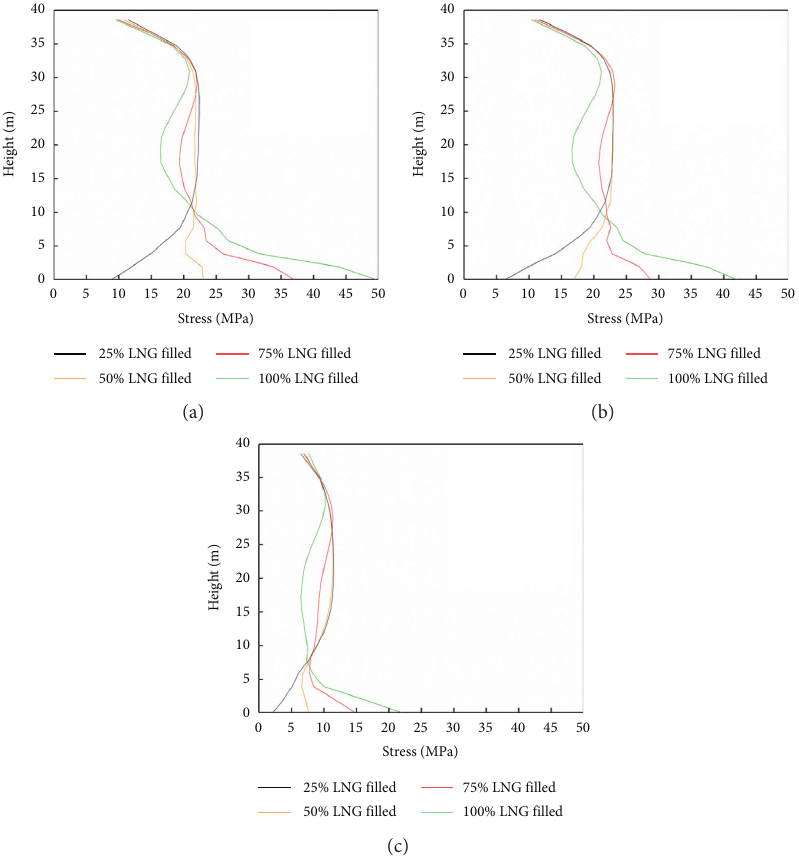
Figure 13: Distribution of the von Mises stress on the outer tank with height along different paths. (a) Path A. (b) Path B. (c) Path